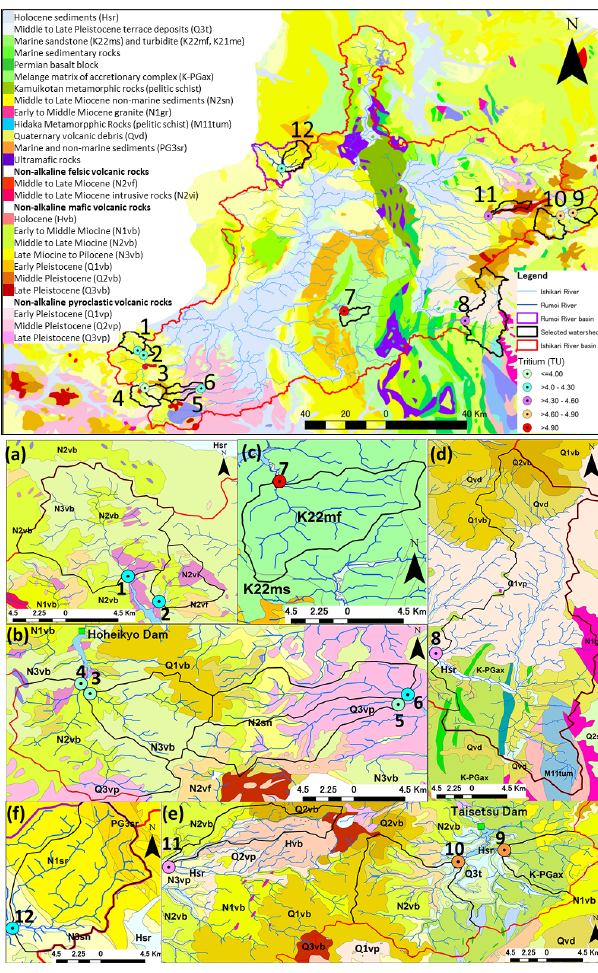
Figure 3. Geology of the study area from AIST (2012), with zoomed-in views of the 12 study watersheds (a–f) . Analysed tritium concentrations are demonstrated in colour code.